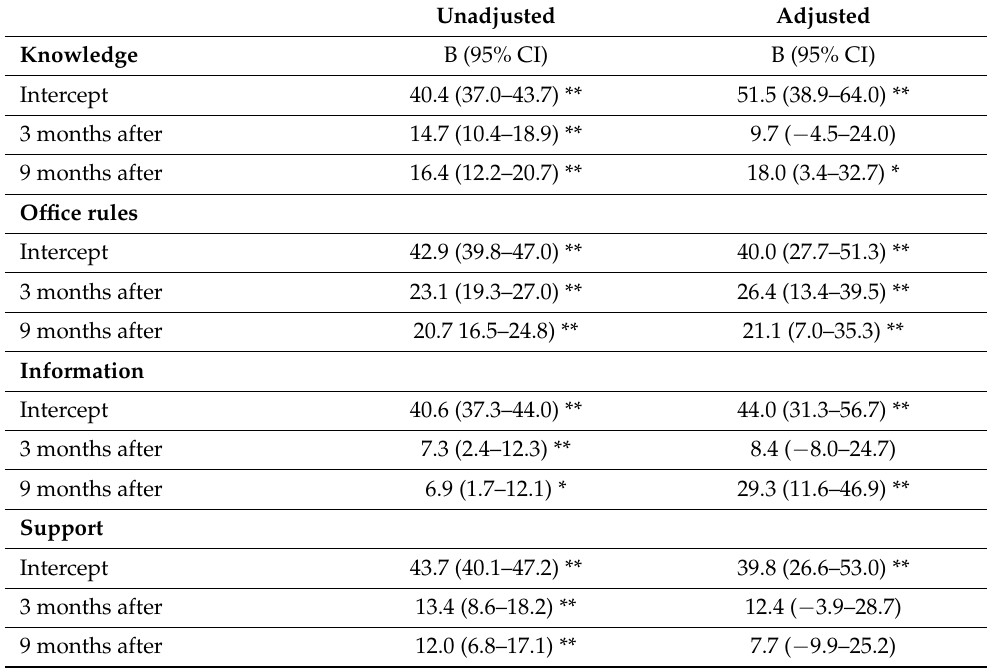
Table 2. Changes in satisfaction with knowledge, office rules, information and support three and nine months after relocation compared with before relocation. Estimates (B) indicate the change compared with before relocation ( n = 696–699).